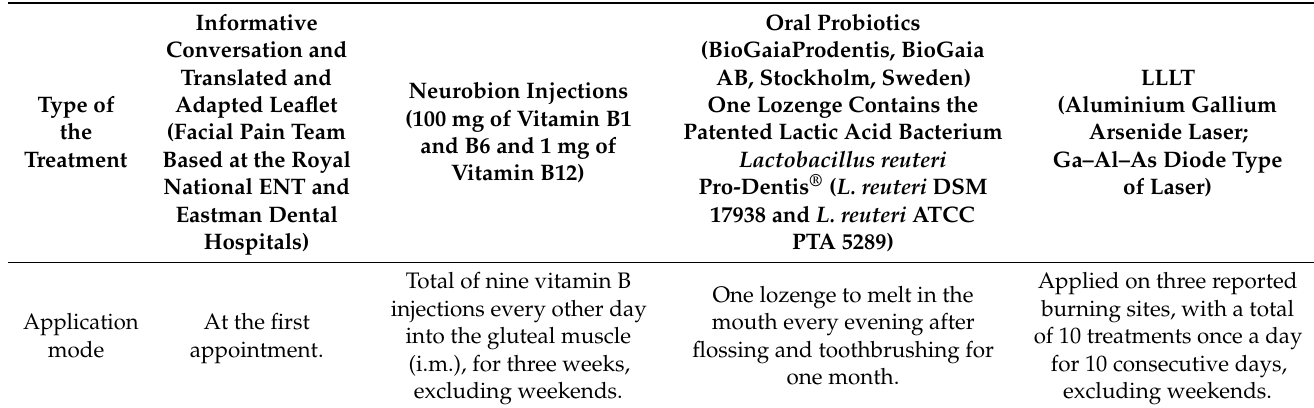
Table 1. Treatments and components of the products used in this study.